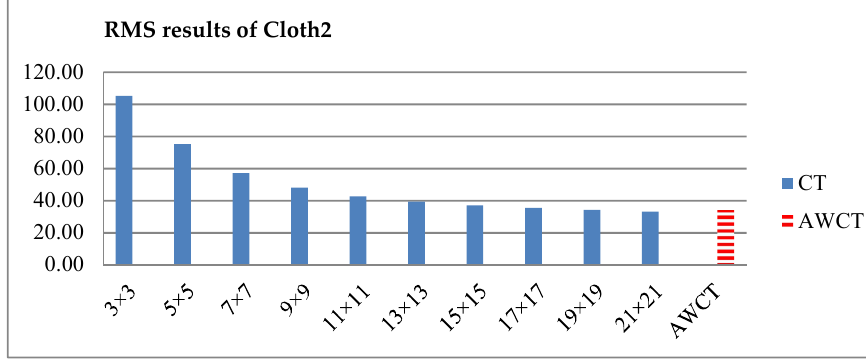
Figure 18. RMS comparison results of Cloth2 between AWCT and CT.